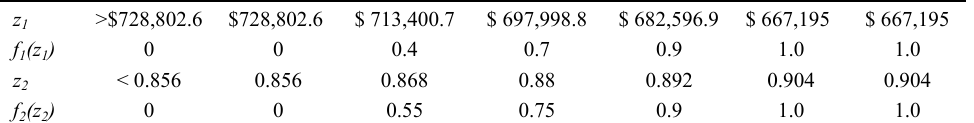
Fig. 6. Piecewise linear membership function (z 1 ,f 1 (z 1 )) Fig. 7. Piecewise linear membership function (z Table 5. Piecewise linear membership functions